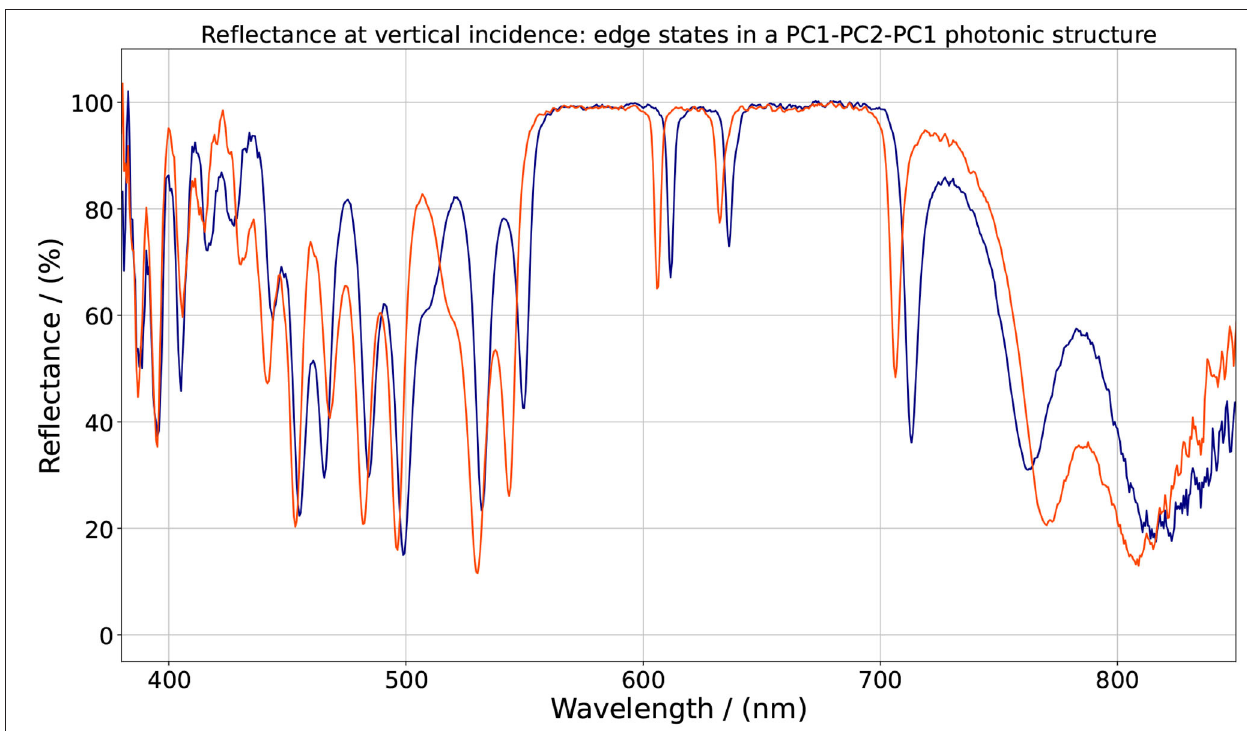
FIGURE 14 | Experimental reflectance presenting 4 narrow reflectance dips in the middle and at the edges of the bandgap. These dips correspond to optical Tamm states in the symmetric structure constituted by 3 photonic crystals. The first and third photonic crystals have 7 unit cells of Ta 2 O 5 and SiO 2 of quarter wavelength thickness, respectively. The central PC has 3 unit cells of the same materials with nominal thickness of 200 and 100 nm, respectively. Differences between theoretical and effective values of the thickness of each layer depend on the evaporation conditions and are responsible for shifts in the bandgap and position of the resonances.